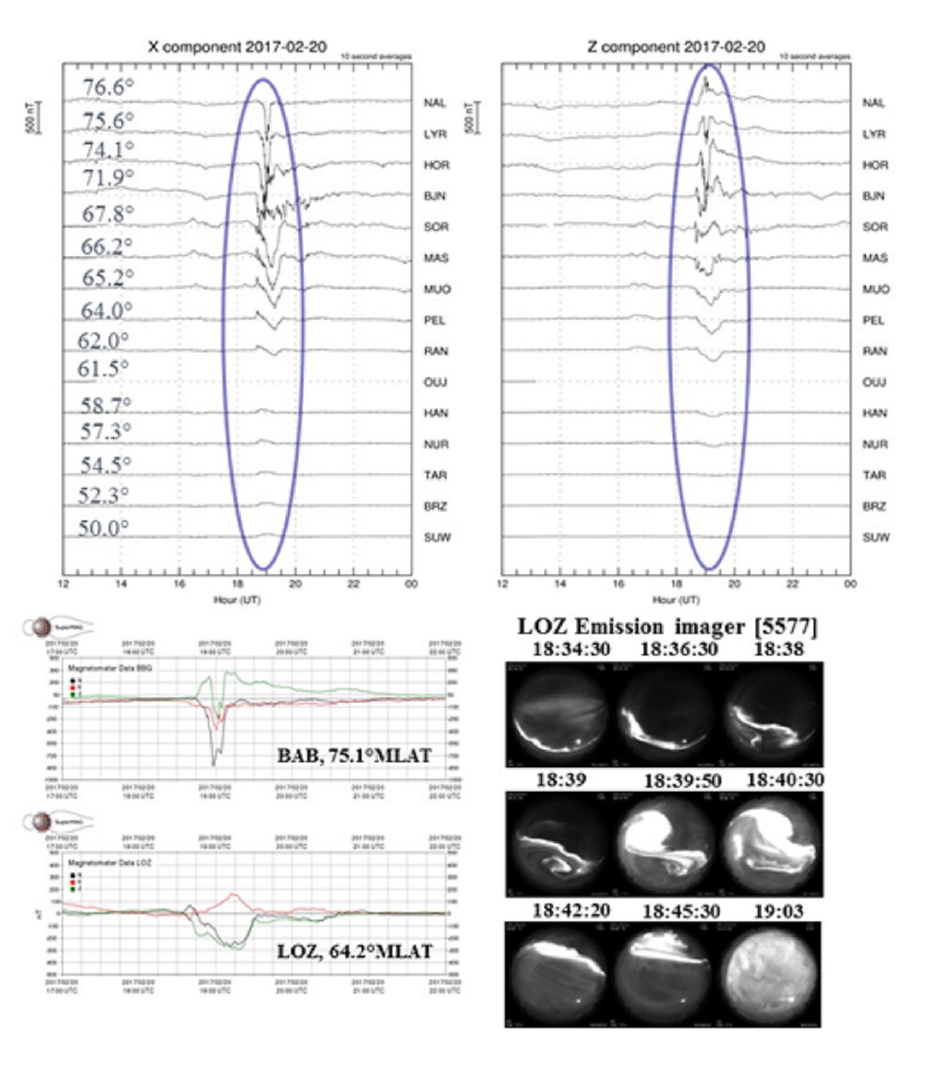
Fig.2. The development of the substorm at 18:40 UT on 20 February 2017 by IMAGE NAL-PPN chain X and Z magnetic components data (upper left and right panels, respectively), and by PGI data: magnetic field components at Barentsburg and Lovozero (left bottom panels) and 5577Å emission data at Lovozero (right bottom